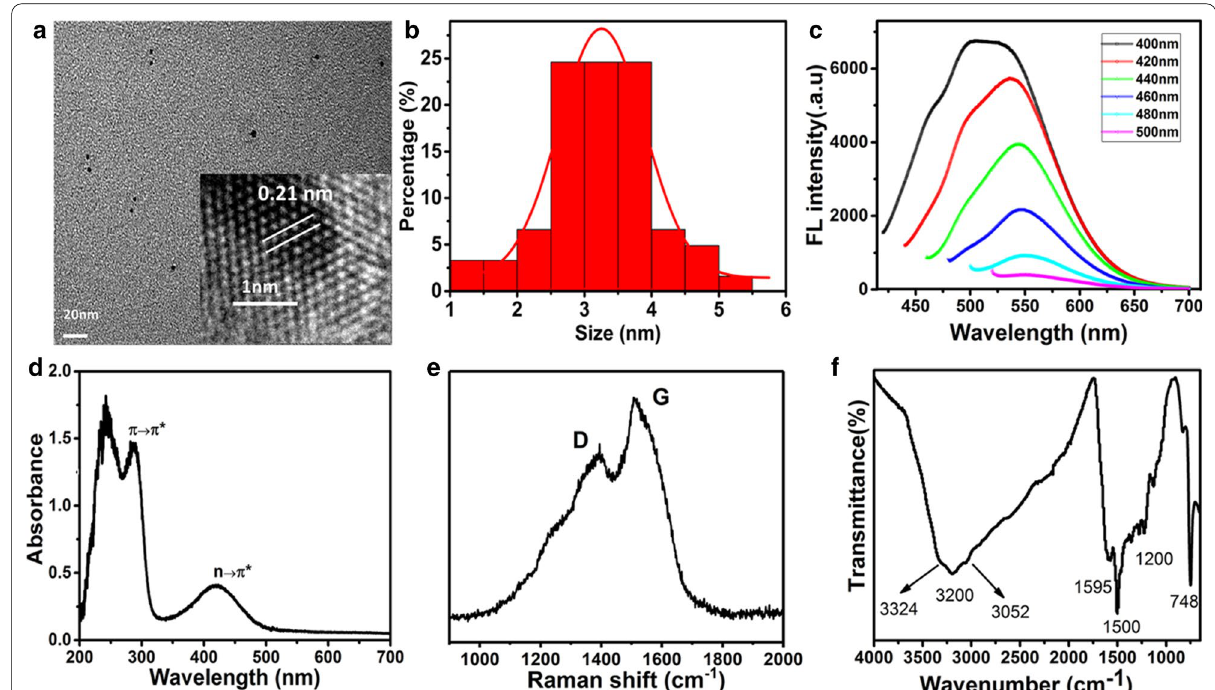
Fig. 1 Characterizations of CQDs. A TEM images of CQDs (inset, high resolution TEM images); B Size distributions of CQDs; C UV–vis absorption spectra of the CQDs; D The FL spectrum of the CQDs with excitation wavelengths from 400 to 500 nm in 20 nm increments; E , F Raman spectrum of CQDs and FTIR spectrum of